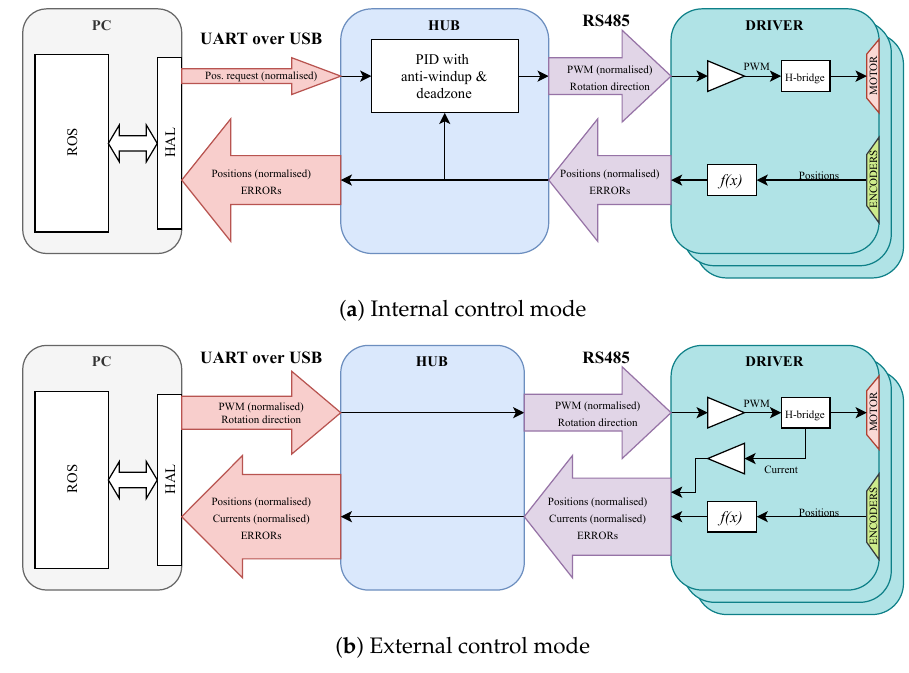
Figure 12. Schematics of PUT-Hand control system in selected